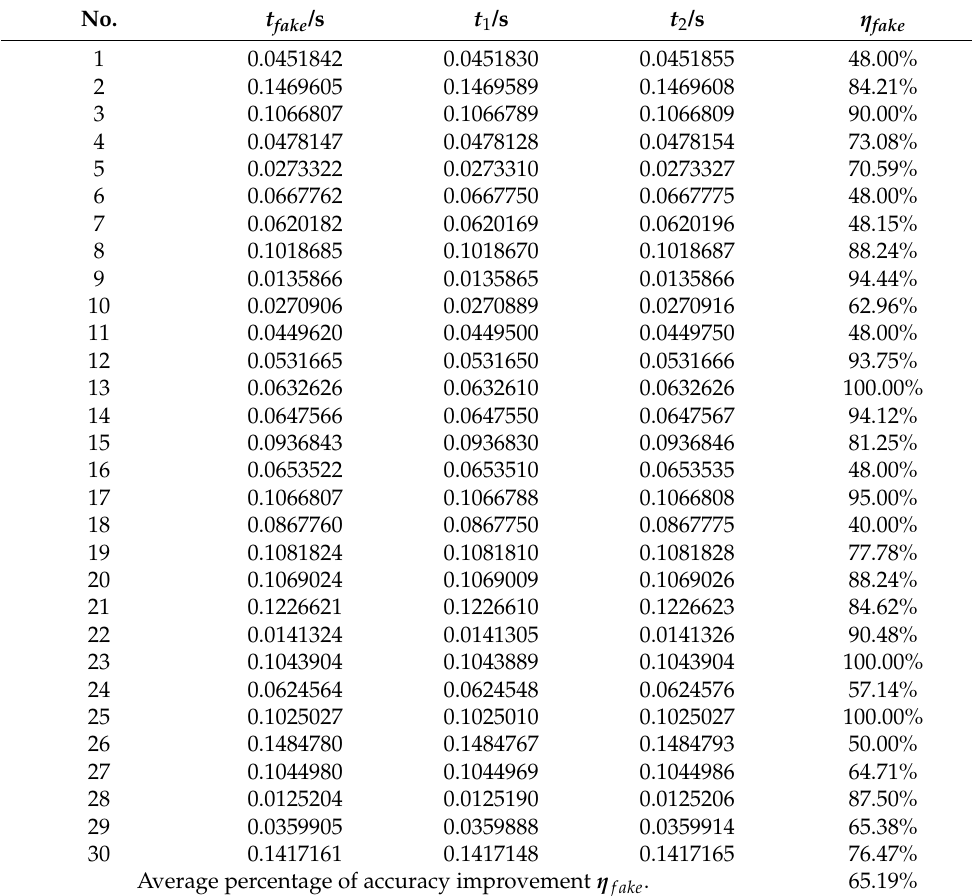
Table 2. Arrival time of traveling wave head and accuracy improvement